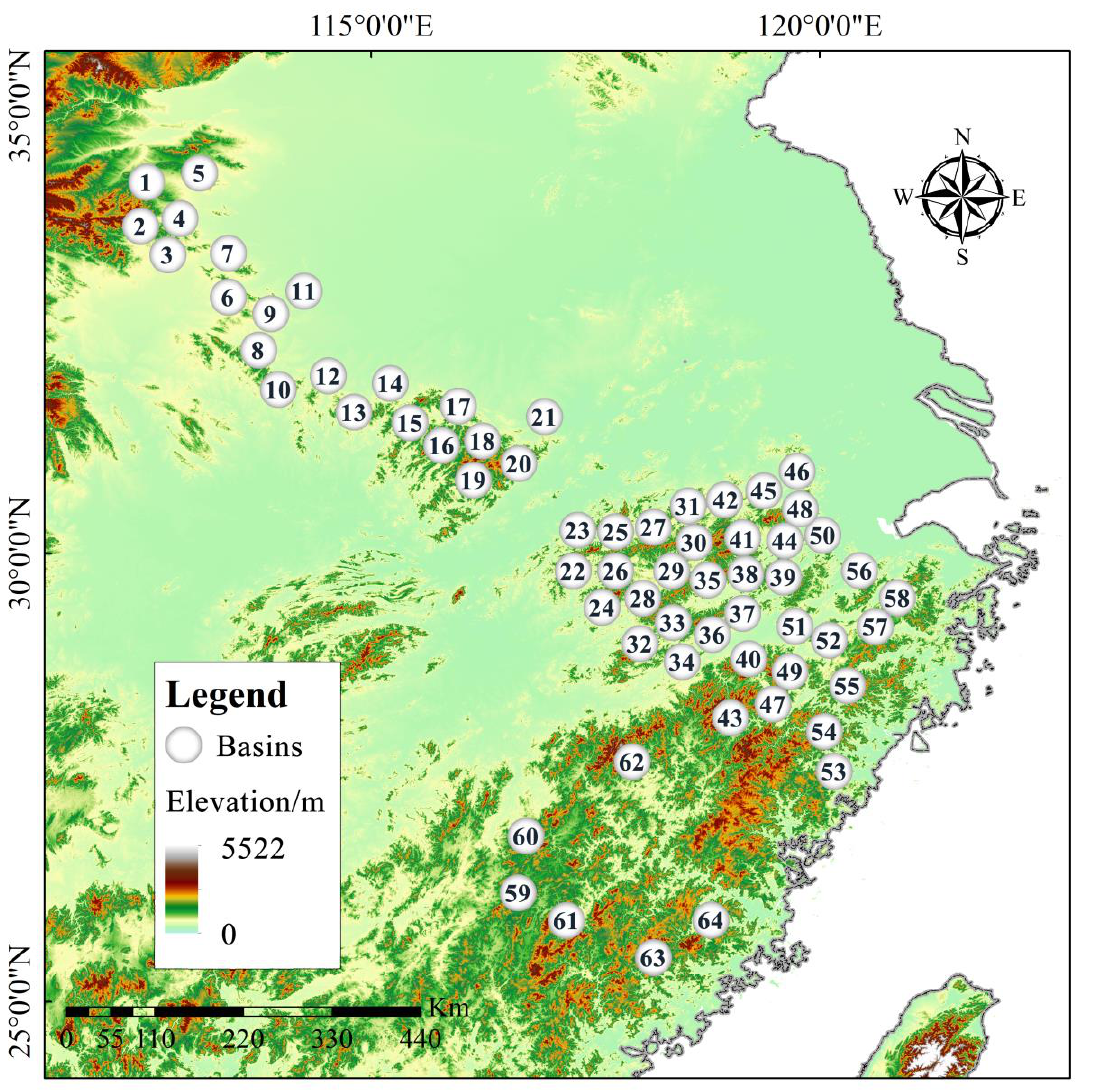
Figure 1. The spatial distribution of 64 mountainous basins used in the study.